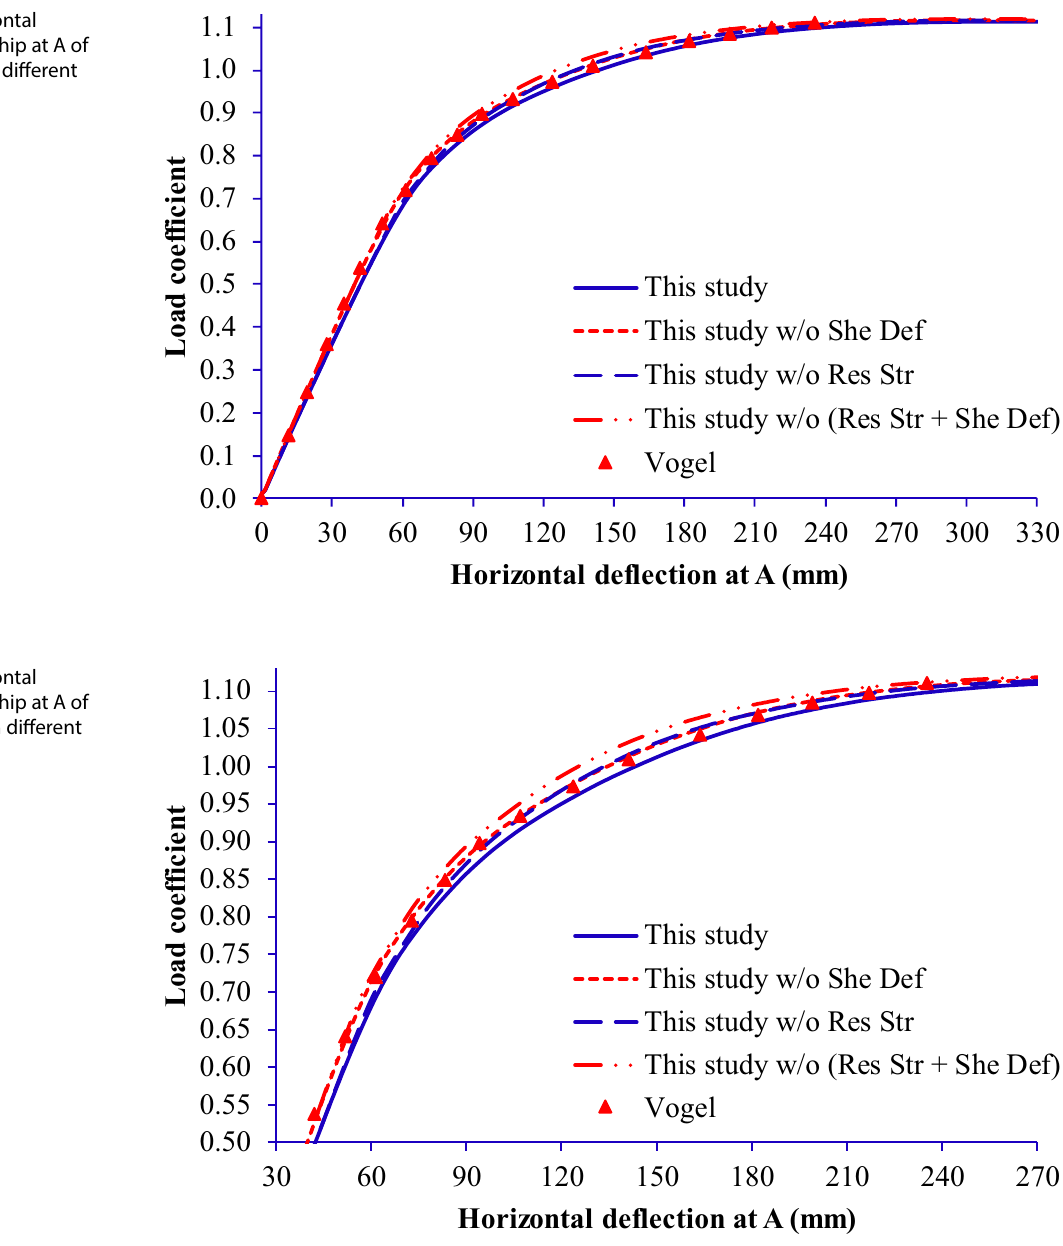
Fig. 13 Load-horizontal deflection relationship at A of six-story frame with different